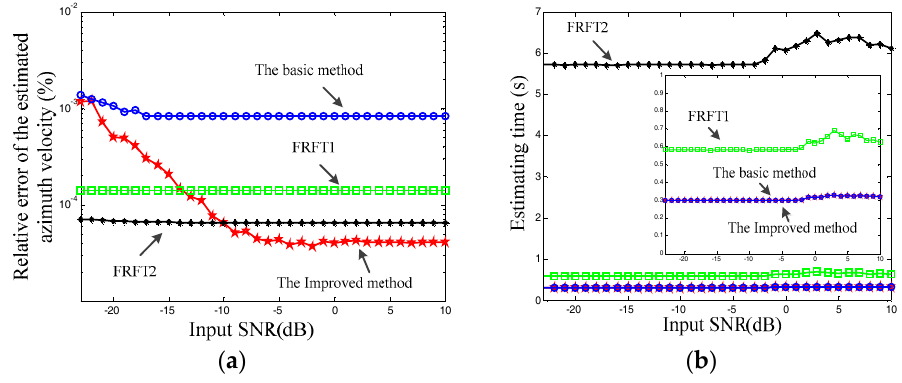
Figure 4. Doppler rate estimation comparison results. ( a ) estimation accuracy comparison; ( b ) computational complexity comparison.